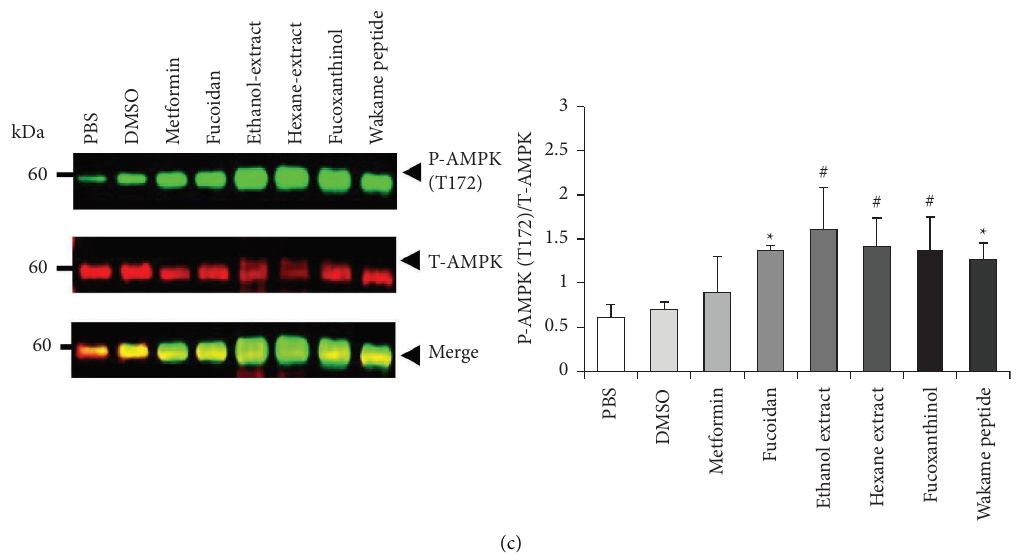
Figure 2: Efect of wakame components on AKTand AMPK phosphorylation and GLUT4 levels in C2C12 cells. Diferentiated C2C12 cells were treated with PBS, DMSO, metformin (1mM), fucoidan (1 mg/mL), ethanol extract (50 μ g/mL), hexane extract (50 μ g/mL), fucox- anthinol (1 μ g/mL), or wakame peptide (100 μ g/mL) for 24h before lysis. Te lysates were analyzed with Western blot using (a) GLUT4, (b) P-AKT (s473) and T-AKT, and (c) P-AMPK (T172) and T-AMPK antibodies and quantifed. Te level of GLUT4 was normalized by that of GAPDH. Te intensity of P-AKTand P-AMPK bands was normalized by that of their respective total protein bands. Te data are presented as mean ± SD ( n � 4). Te data were analyzed with one-way ANOVA combined with the Tukey test. ∗ p < 0 . 05, compared to PBS; # p < 0 . 05, compared to DMSO.